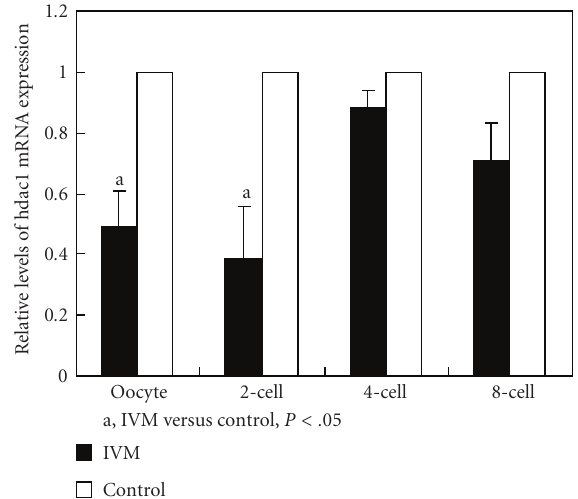
Figure 4: mRNA expression of HDAC1 in oocytes and embryos. The comparison of HDAC1 mRNA expression was made between IVM and control groups. Summary data showed the relative expression levels of HDAC1 in oocytes and embryos after real-time PCR analysis. The relative mRNA levels represent the amount of mRNA expression normalized with